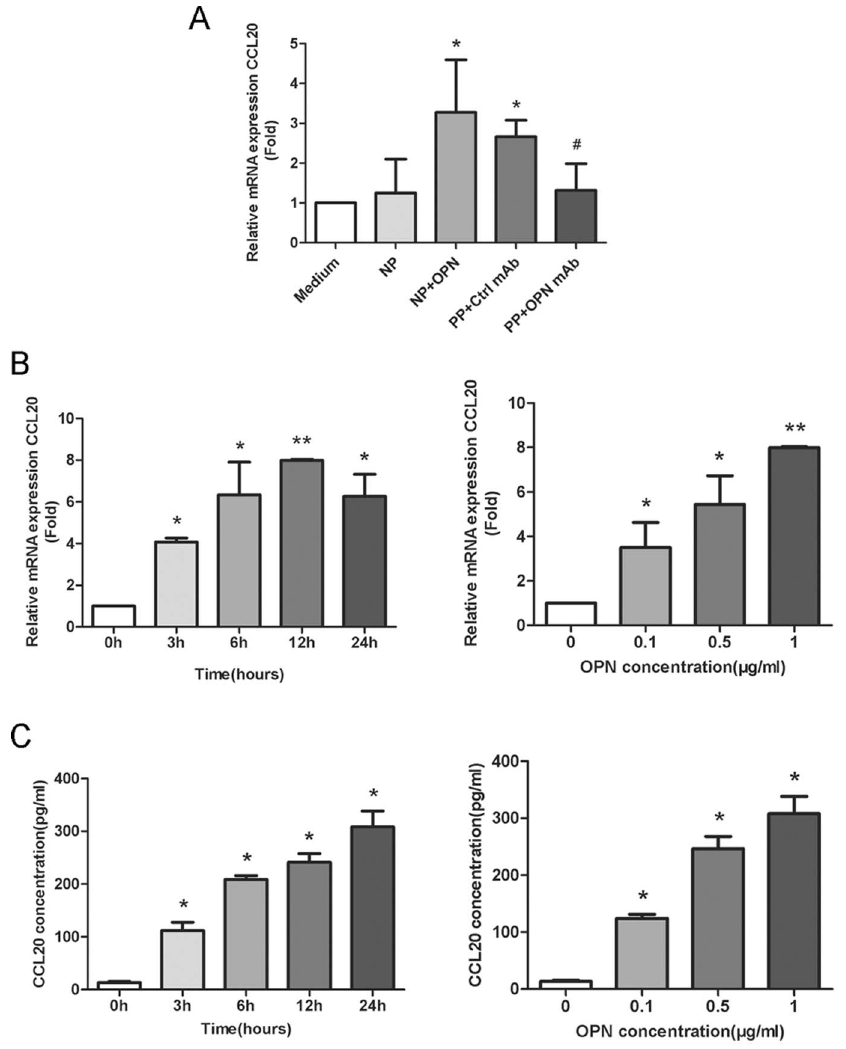
Figure 3. OPN induced CCL20 expressions in CD4 + T cells. (A) Induction of CCL20 level in plasma from uGD patients and healthy controls. Medium: RPMI 1640; NP, normal plasma; NP + OPN: normal plasma added with 0.1 m g/ml OPN; PP, patient plasma; PP + OPNmAb : patient plasma pretreated with 5 m g/ml OPN-neutralizing antibody for 30 min. *, P , 0.05 versus medium control; # , P , 0.05 versus Ctrl mAb. (B, C) OPN induced CCL20 mRNA expressions (B) and protein levels (C) in a time and dose-dependent manner. For time course, the PBMCs were cultured in the presence of human recombinant OPN (1 m g/ml) and analyzed at the indicated time points. To determine the dose dependent manner of CCL20 expression, the PBMCs were cultured for 12 hours with OPN at the indicated concentrations. CD4 + T cells and culture medium were then purified and analyzed. Shown are representative results from 3 independent experiments with separate specimens. All data were presented as mean 6 SEM. *, P , 0.05; **, P , 0.01, versus medium